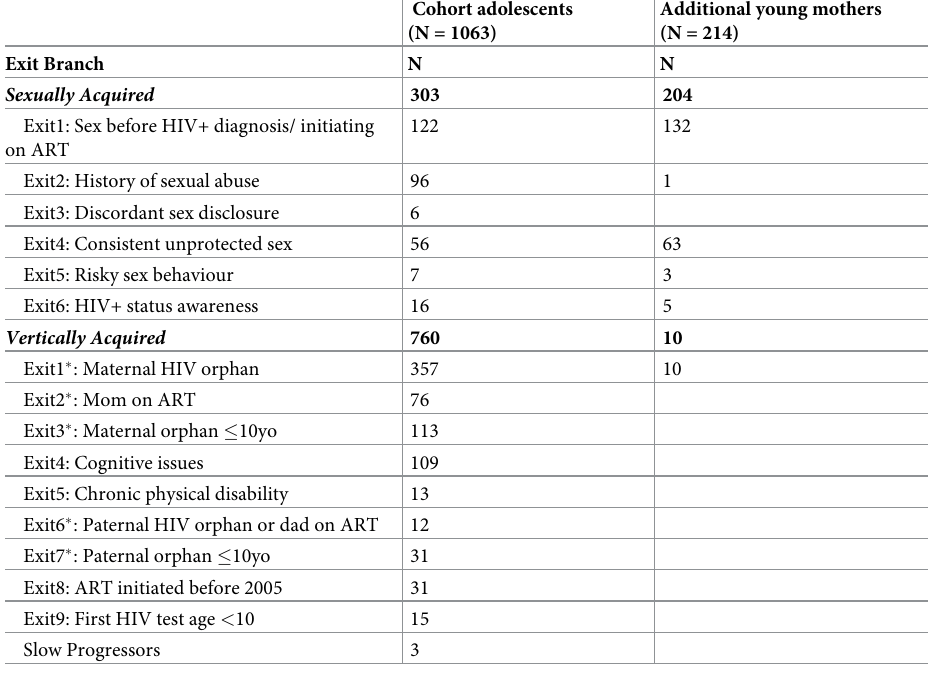
Table 3. Frequency of adolescents’ exit branch by mode of HIV acquisition determined by logic